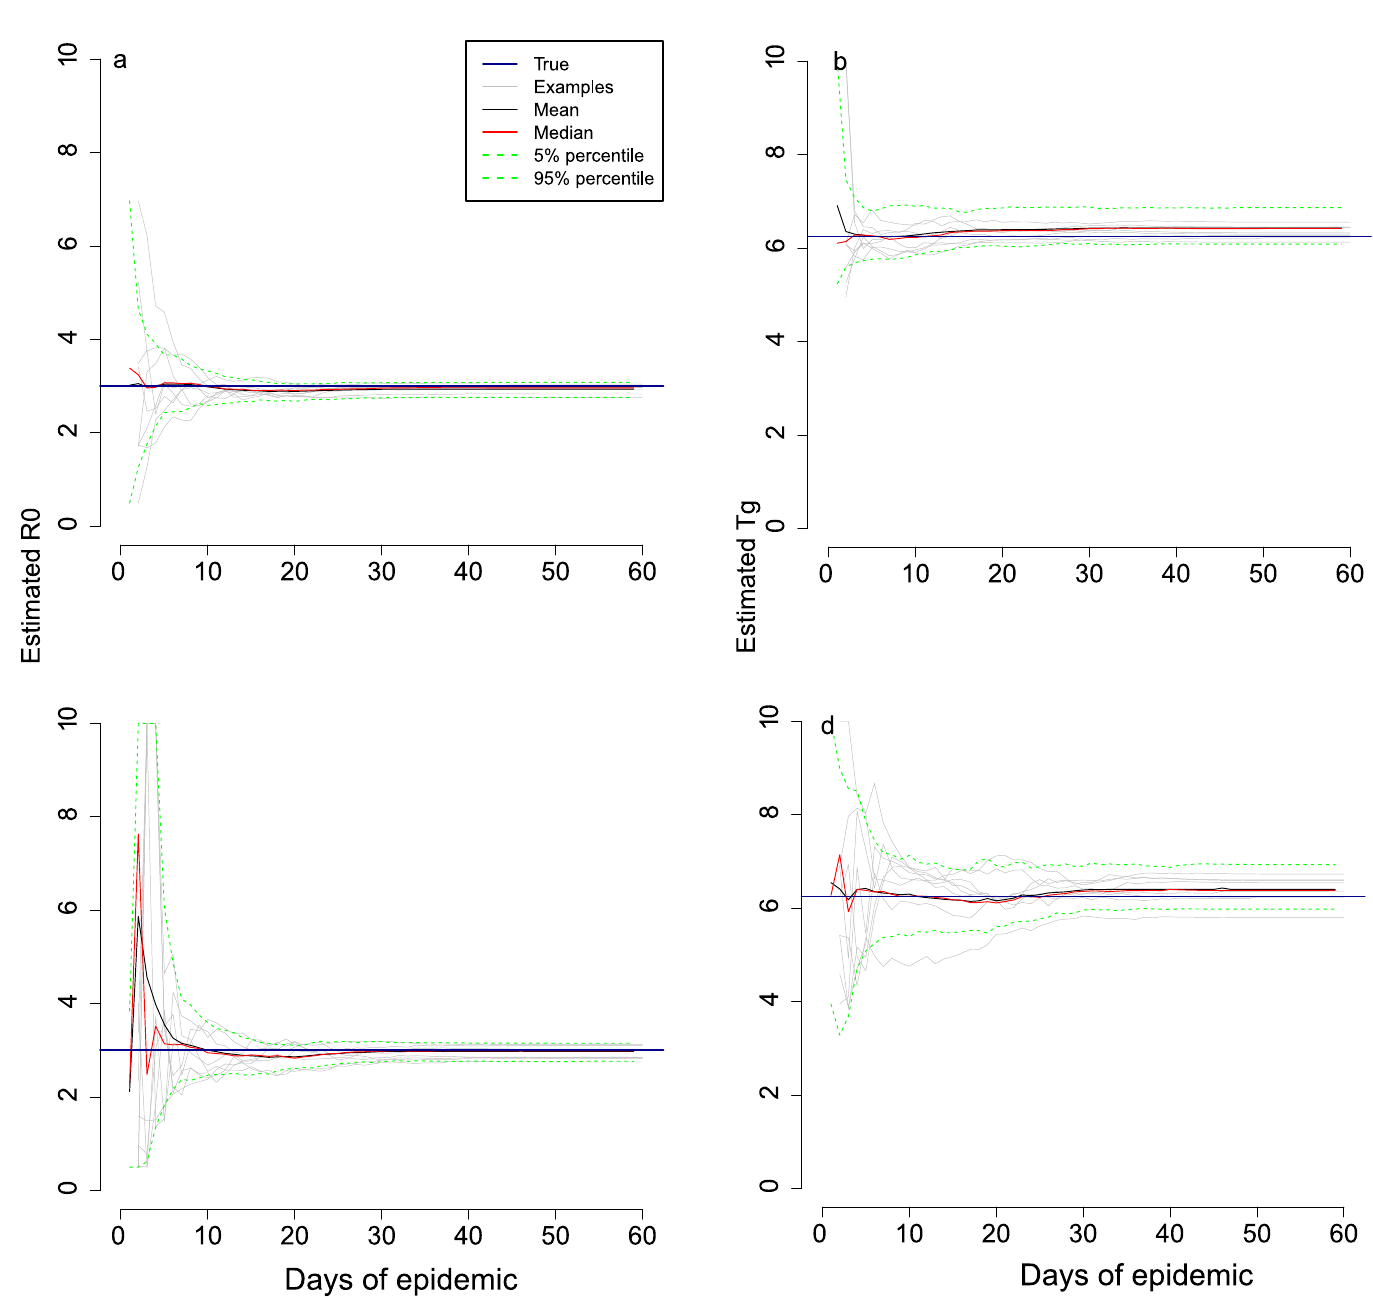
Fig 3. Univariate and bivariate parameter estimation from simulated daily data for Scenario 2. Part a shows real-time univariate estimates of R 0 in which the true value of T g was assumed known. Part b shows real-time univariate estimates of T g with R 0 assumed known. The results of jointly estimating R 0 and T g are shown in parts c ( R 0 ) and d ( T g ). Scenario 2 is as per Fig 1B with R 0 = 3.0, T g = 6.25. The epidemic was simulated in a population of 1,000 people all of whom were initially susceptible, other than 100 who were infectious on day 1. Grey lines trace the corresponding estimates of 8 arbitrary epidemics. Black lines represent the average of 100 estimates at that time point, red lines represent the median, and the green dotted lines are the 5% and 95% prediction intervals for 100 epidemics. The dark blue solid horizontal lines show the true parameter values.